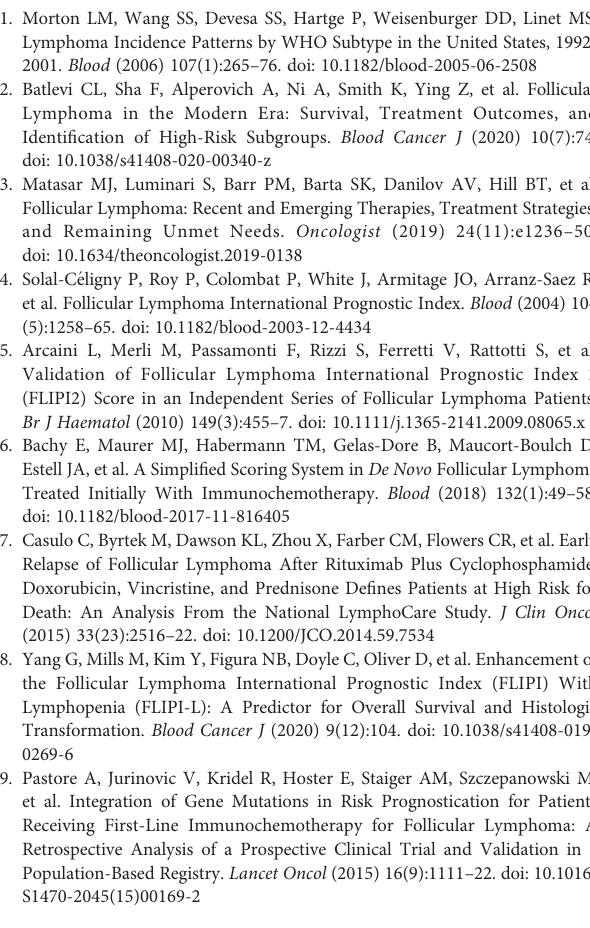
were absolute age and m7-FLIPI scores.